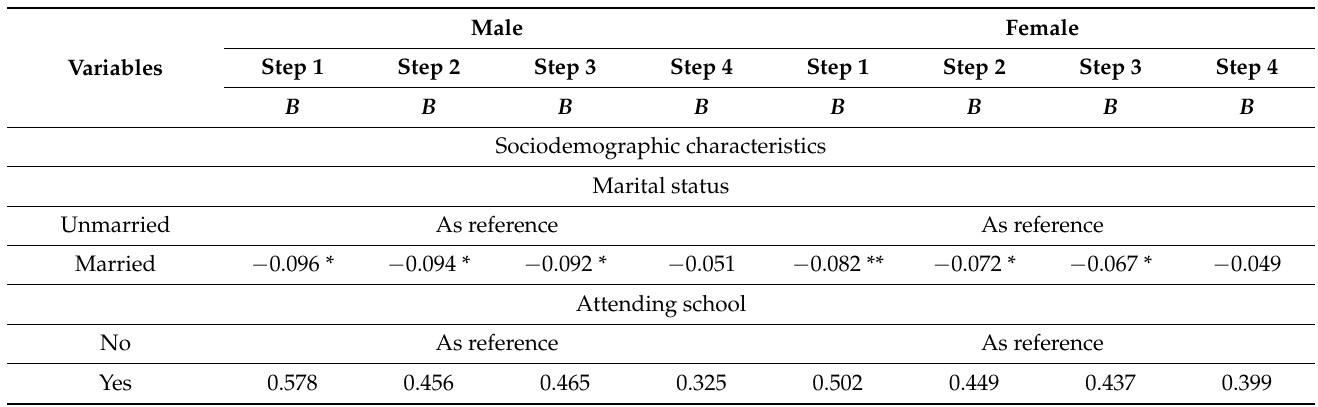
Table 5. Hierarchical multiple linear regression on negative affect by psychosocial and health-related factors in the 19–25 y age group based on